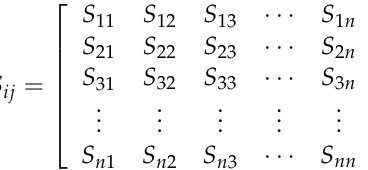
Table 2. Description of landscape metrics.